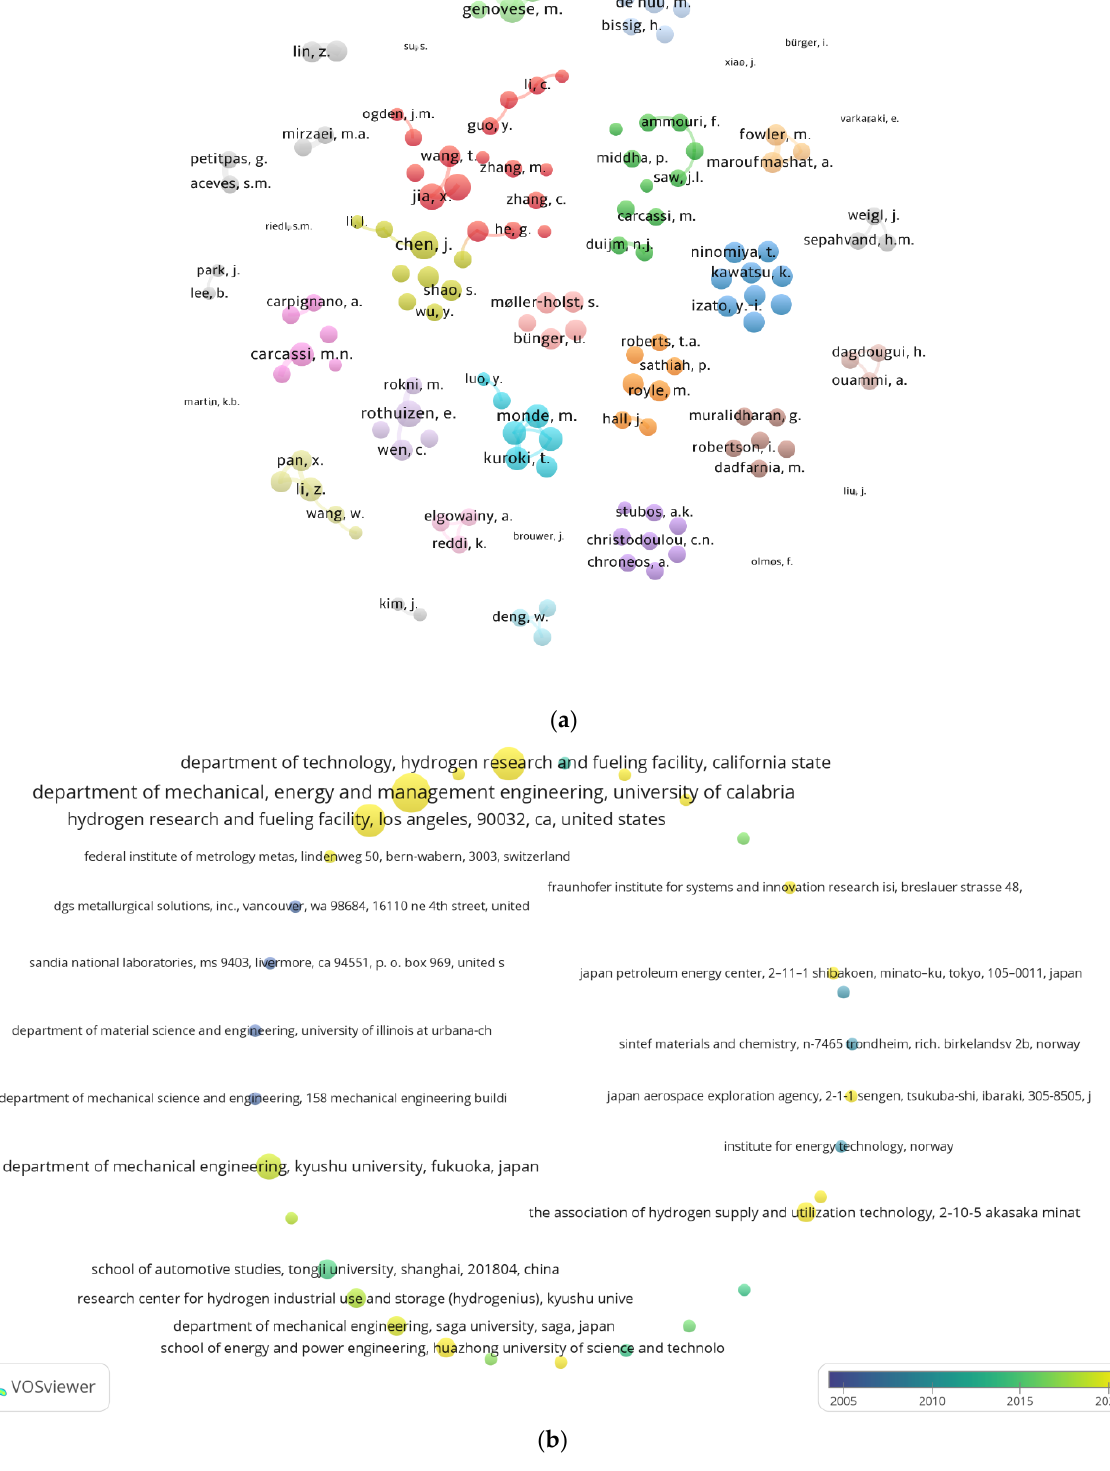
Figure 2. Clusters of authors according to VOSviewer ( a ) and Organizations’ collaborations ( b ), by processing Scopus database.